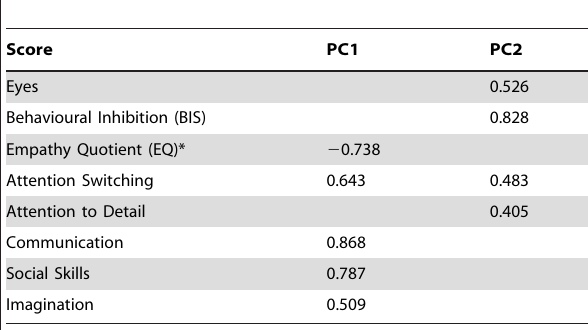
Table 6. Principal components 1 and 2 (loadings . 0.4) from the principal components analyses of the Eyes, BIS, EQ and AQ subscale